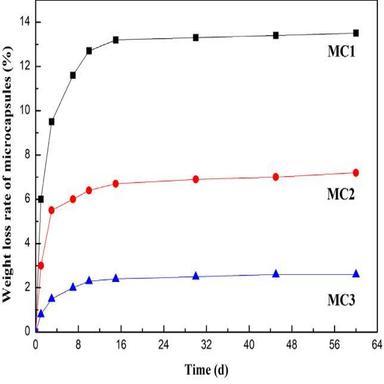
Weight loss rates of microcapsules with different shell composition.